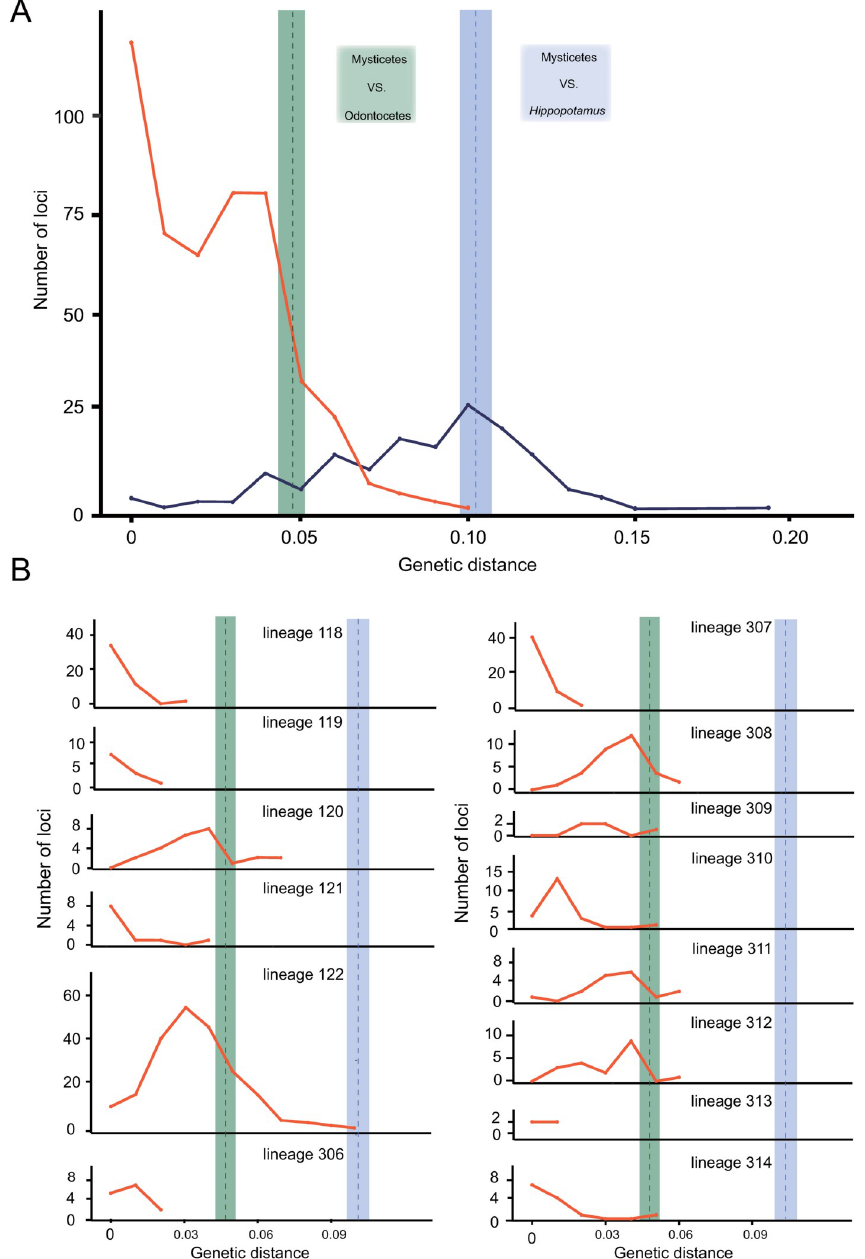
Fig 5. Evolutionary dynamics of cetacean ERVs. ( A ) Distribution of the genetic distance between 5’- and 3’ LTRs of complete ERVs in 315 cetacean ERV lineages. Blue and orange lines represent the distribution of the genetic distance between 5’- and 3’ LTRs of complete ERVs in the LTW and the SHS ERV lineages, respectively. The purple and green boxes represent 95% highest posterior distributions (HPD) of the genetic distance of introns between B . acutorostrata and H . amphibious (reflecting the divergence between cetaceans and hippopotamuses) and between B . acutorostrata and O . orca (reflecting the divergence between mysticetes and odontocetes) with dashed lines as the means. ( B ) Distribution of the genetic distance between 5’- and 3’- LTRs of complete ERVs in different cetacean ERV lineages under the SHS scenario. The purple and green boxes represent 95% HPD of the genetic distance of introns between B . acutorostrata and H . amphibious and between B . acutorostrata and O . orca , respectively, with dashed lines as the means.